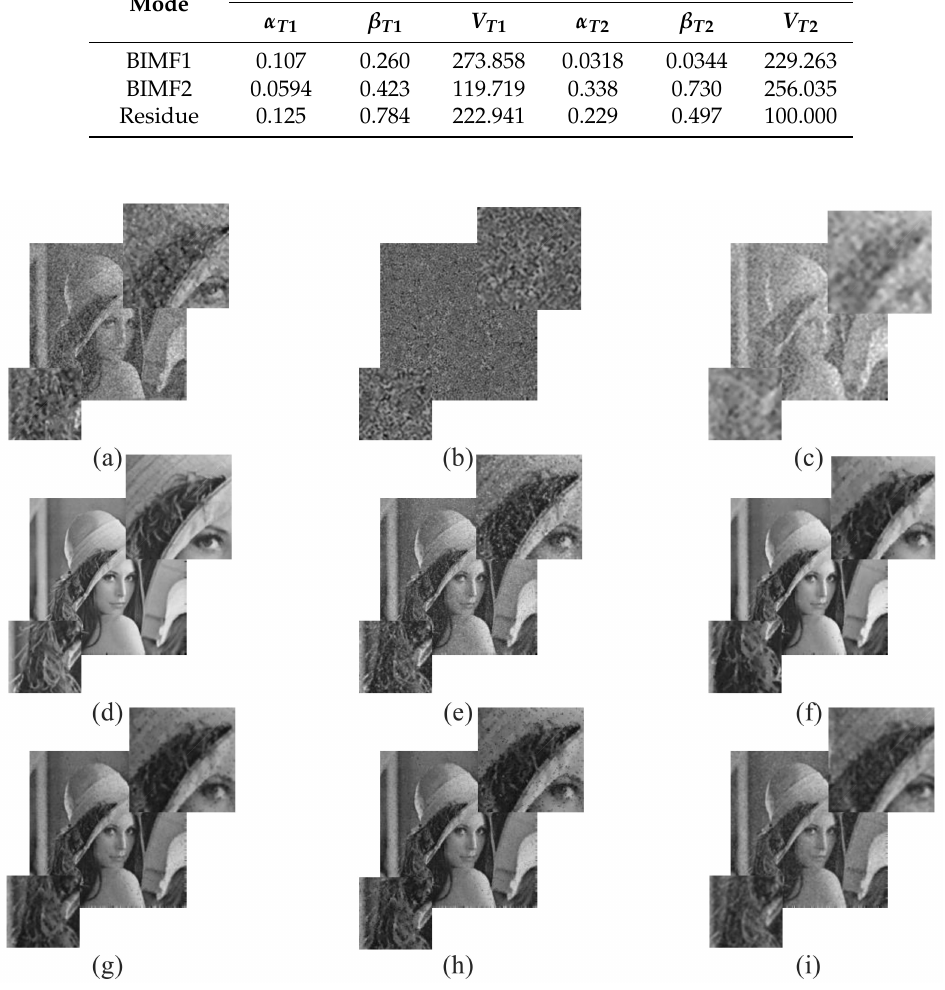
Table 2. The experimentally obtained optimal parameters data for each decomposed component corresponding to the Lena and Pepper image. Lena